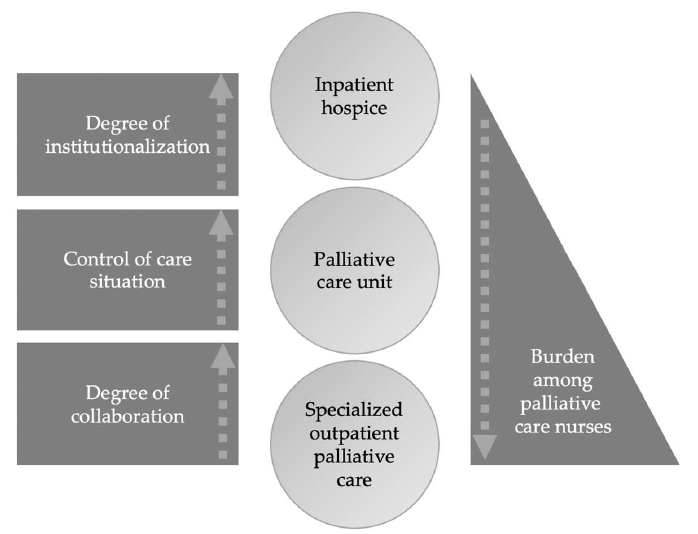
Figure 5. Summarized mixed methods findings.